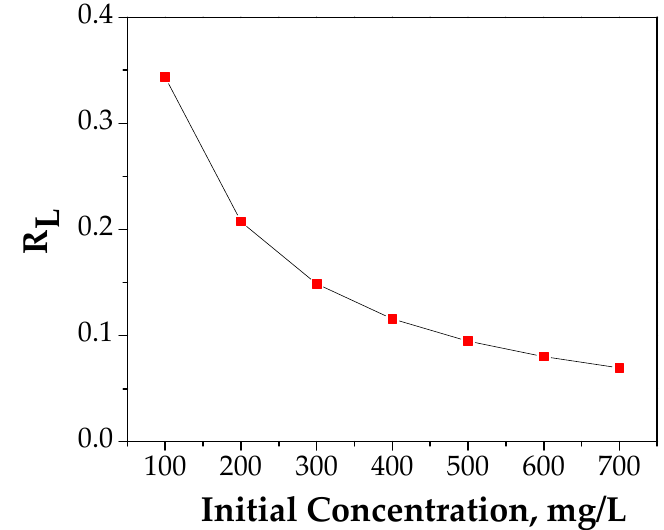
Figure 11. Plot of separation factor vs. initial Cu (II) concentration.